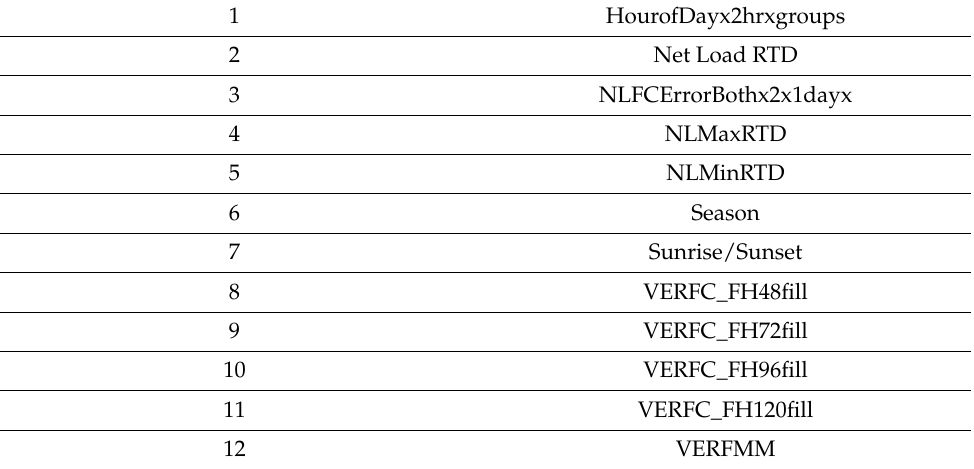
Table 3. k = 12 features used in SVR and NN